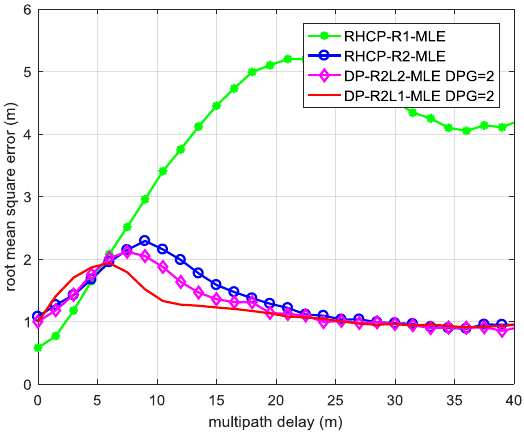
Figure 5. The RMSE of the TOA estimation of LOS signal using MLE with different signal models in the two-path environment defined by Strong LHCP Signal Case 2 when DPG = 2.